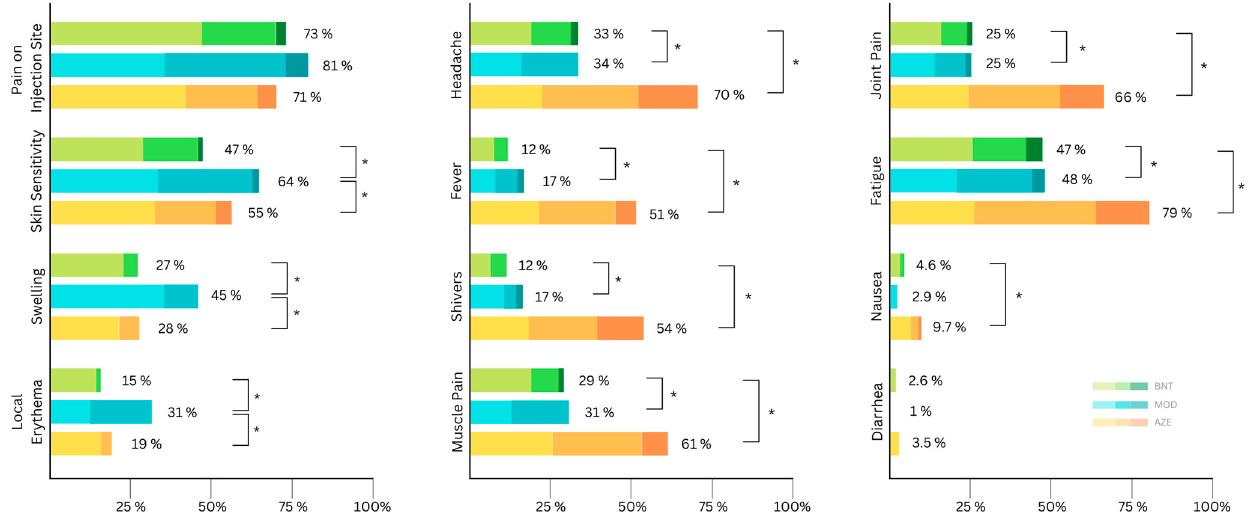
Figure 1. Distribution of self-reported side effects according to symptom severity (mild, moderate, severe) after the first vaccination (AZE:AstraZeneca (ChAdOx1 nCov19); BNT: Biontech/Pfizer (BNT162b2); MOD: Moderna (mRNA-1273)). Asterisks indicate significant differences in severity. Table 3. Comparison of side effects in terms of symptom severity after different vaccines AZE vs. BNT AZE vs. MOD BNT vs. MOD